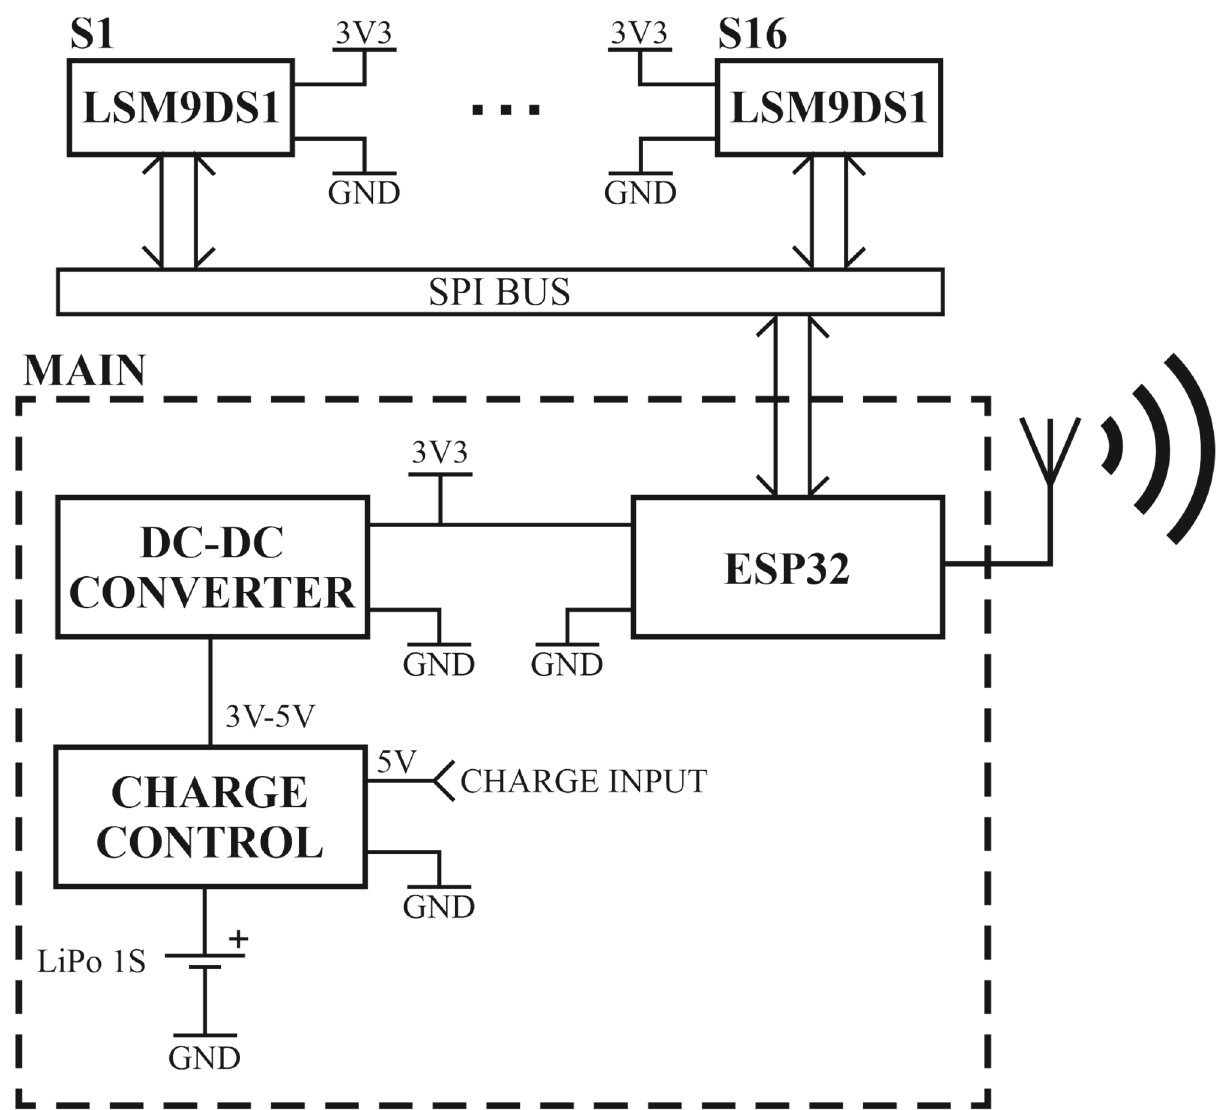
Figure 3. Block diagram of the wearable sensor system (WSS).